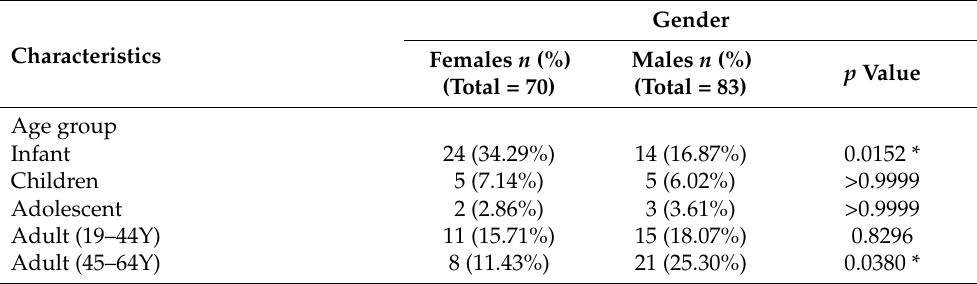
Table 1. Comparison of the demographic and clinical characteristics of ICU patients infected with E. cloacae.